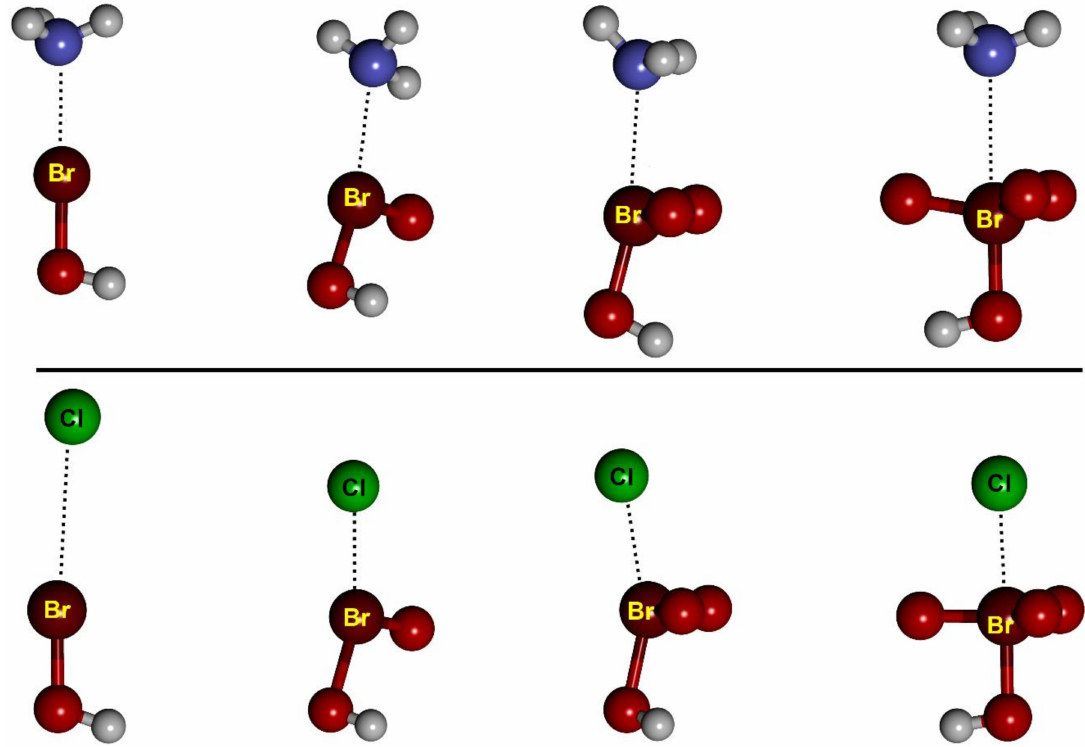
Figure 3. The optimized structures of the XB complexes between HBrO n and either NH 3 or Cl − . Table 3. The interaction energies ( ∆ E in kcal · mol − 1 ) and interatomic distances (Å) of the hydrogen bonding (HB) and halogen bonding (XB) complexes with NH 3